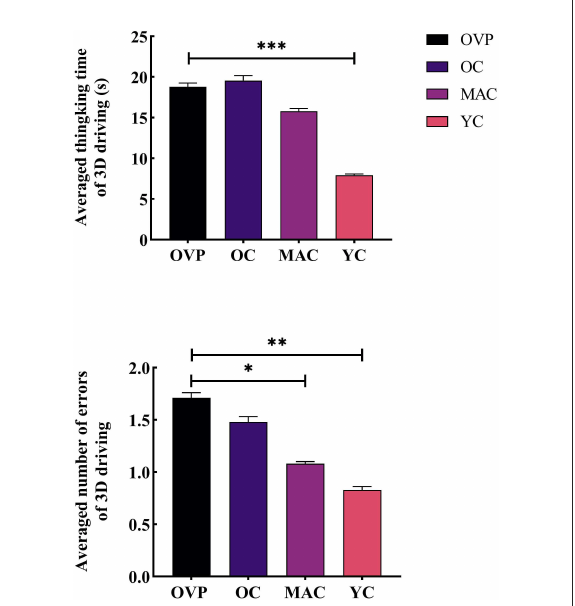
FIGURE5 Time and errors of 3D driving test between groups. (A) Averaged thinking time of 3D driving. (B) Number of Errors of 3D driving. Post-hoc multiple comparisons between groups using OVP group as reference, significantly differences were indicated by the asterisk. OVP, Older vertigo patients; OC, Older controls; MAC, Middle-aged controls; YC, Young controls. * p < 0.05; ** p < 0.01; *** p < 0.001. Error bars indicate the SEM.